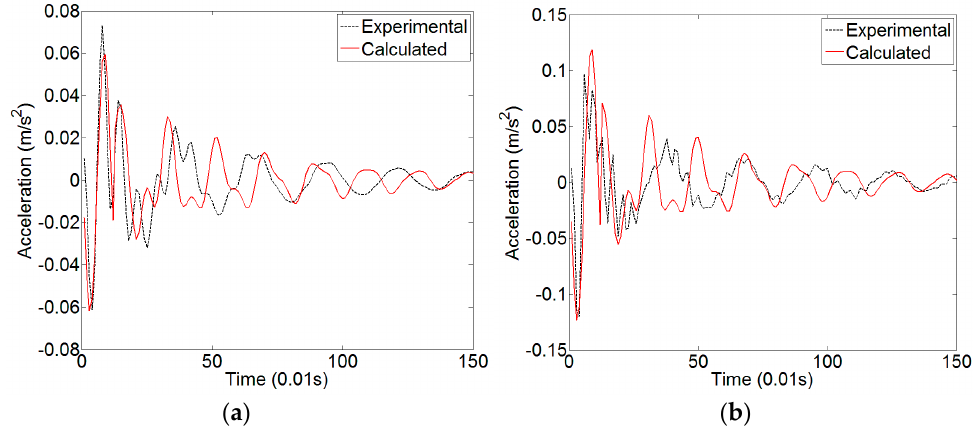
Figure 9. The comparison of the experimental and calculated time history curves: ( a ) Grade 2; ( b ) Grade 8.